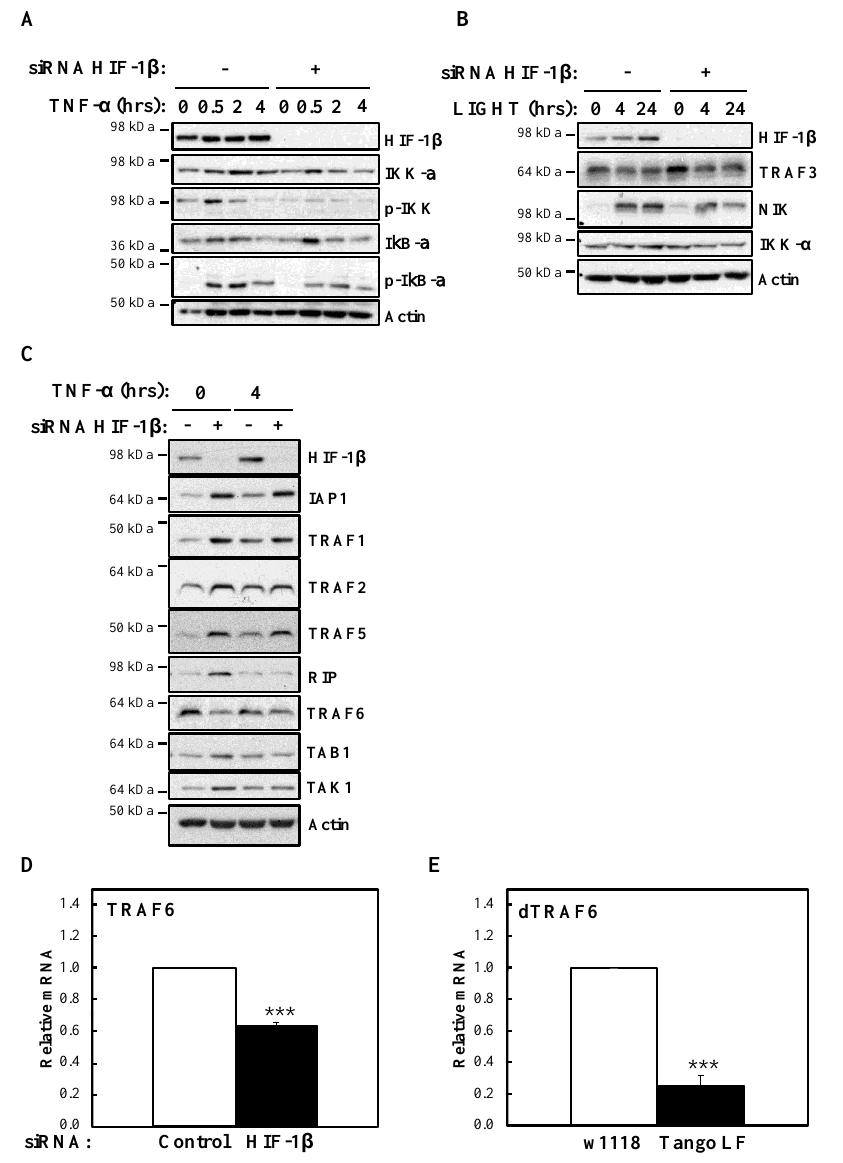
Figure 5. HIF-1 β is required to control TRAF6 levels. ( A ) HeLa cells were transfected with control or HIF-1 β siRNA oligonucleotides. Where indicated, cells where treated with 10 ng / mL TNF- α for the periods of time depicted prior to whole cell lysis and Western blot analysis. Actin was used as a loading control. ( B ) HeLa cells were transfected as in 5A , but where indicated, cells were treated with 100 ng / mL LIGHT prior to whole cell lysis and Western blot analysis. Actin was used as a loading control. ( C ) HeLa cells were transfected as in 5A , but treated with 10 ng / mL TNF- α for 4 h prior to cell lysis and Western blot analysis. Actin was used as a loading control. ( D ) HeLa cells were transfected with control or HIF-1 β siRNA oligonucleotides for 48 h prior to lysis and RNA extraction. Following cDNA synthesis, qPCR was performed using specific primers for TRAF6. Graphs depict mean and SEM from three independent biological experiments. Student t -test analysis was performed and levels of significance determined as follows: *** p < 0.001. ( E ) Wild-type adult flies ( w1118 ) and HIF-1 β loss-of-function flies ( Tango LF ) were used for RNA extraction and cDNA synthesis. qPCR analysis was performed for the levels of dTRAF6 . Graph depicts mean and SEM from three independent biological experiments. Student t -test analysis was performed and levels of significance as follows: *** p <